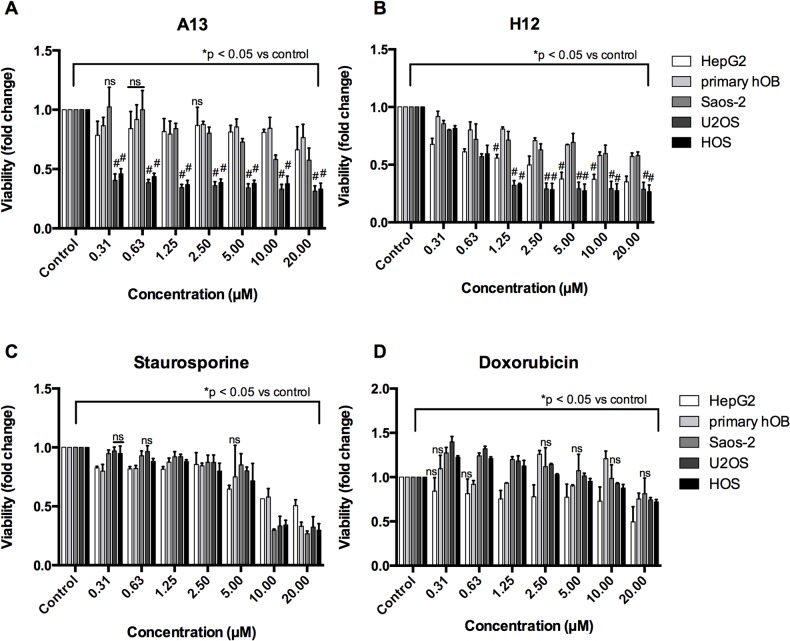
Dose-response analyses in OS cell lines and control cells after compound treatment.Cells were treated for 24h with compounds A13 (A), H12 (B), or with classical drugs staurosporine (C) and doxorubicin (D), respectively. Cell viability was assessed using CtB assay. Shown is fold change of cell viability normalized to DMSO-treated control for each cell type after incubation with increasing concentrations (μM) of the respective substance for 24h. Data are expressed as mean +/- SD from duplicates of three independent experiments. Differences of means were calculated using multiple t test for all cell lines versus primary hOB and all highly significant differences with #p < 0.001 are indicated by hash key (#). Differences of means to control were calculated for all bars and all were significantly different from control with *p < 0.05 indicated by the lines on top of the bars except those bars that are marked with ns = not significant (p > 0.05).